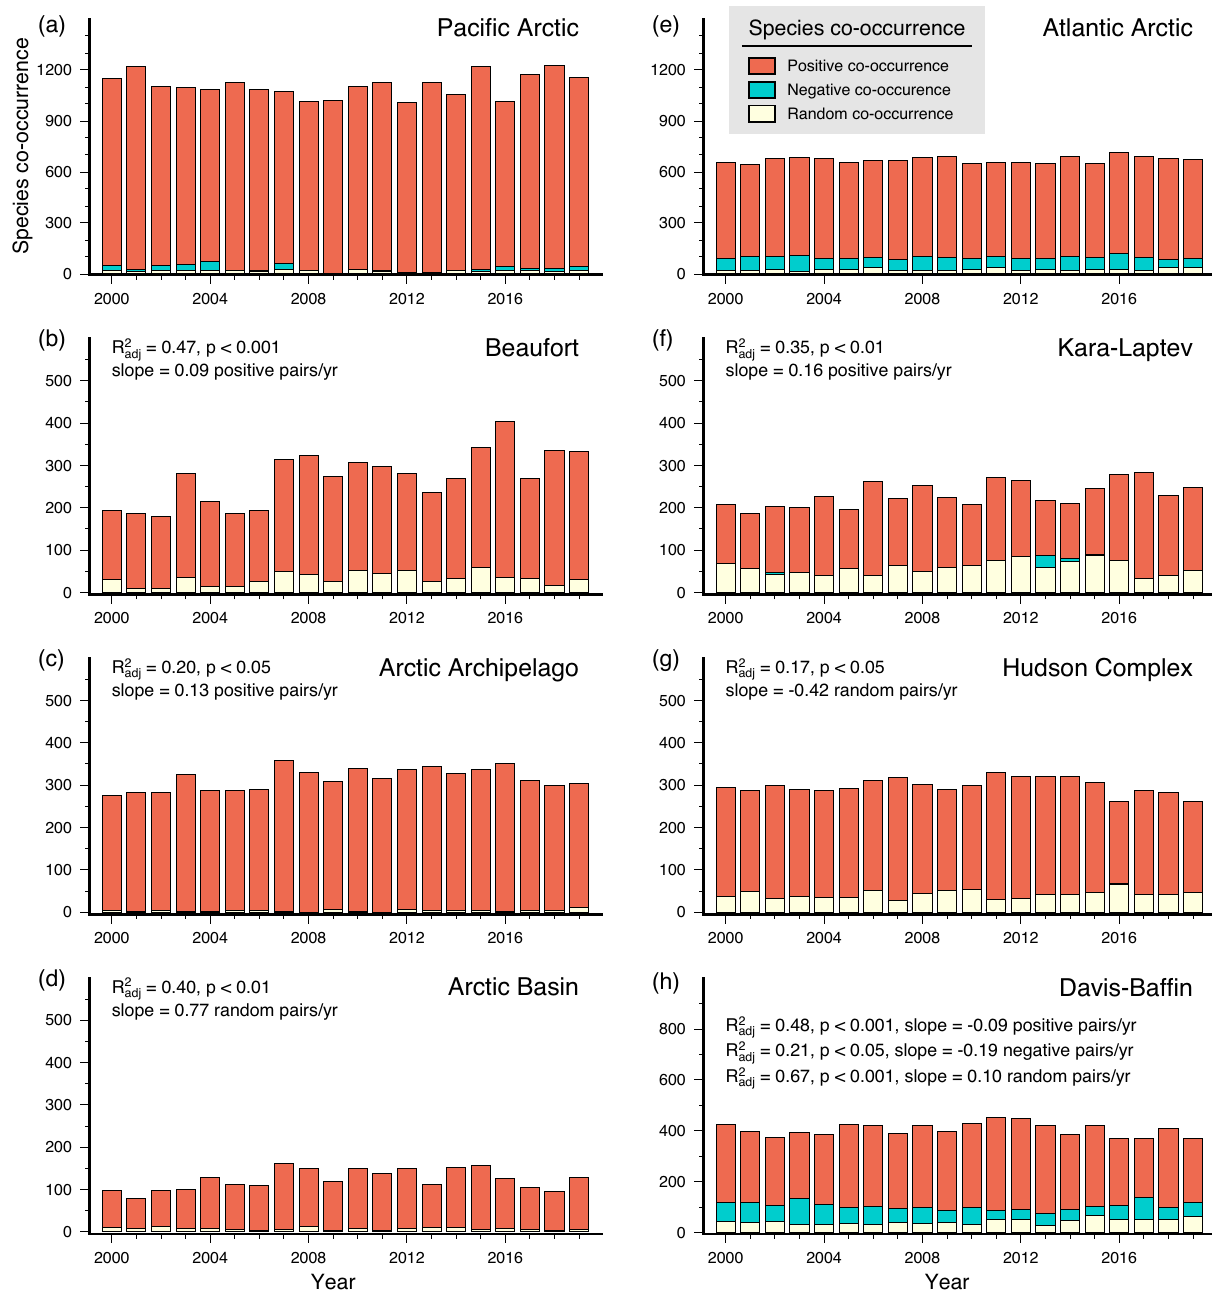
Figure 3. Frequency of positive, negative, and random co-occurrences for all species in the ( a ) Pacific Arctic, ( b ) Beaufort, ( c ) Arctic Archipelago, ( d ) Arctic Basin, ( e ) Atlantic Arctic, ( f ) Kara–Laptev, ( g ) Hudson Complex, and ( h ) Davis-Baffin from 2000 to 2019. Adjusted R 2 (R 2 adj ) and slope are shown for areas exhibiting significant temporal trends in species